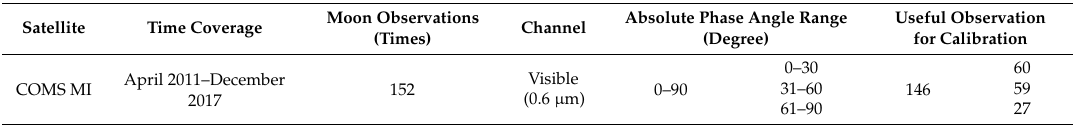
Table 2. Characteristics of COMS MI Moon Observation